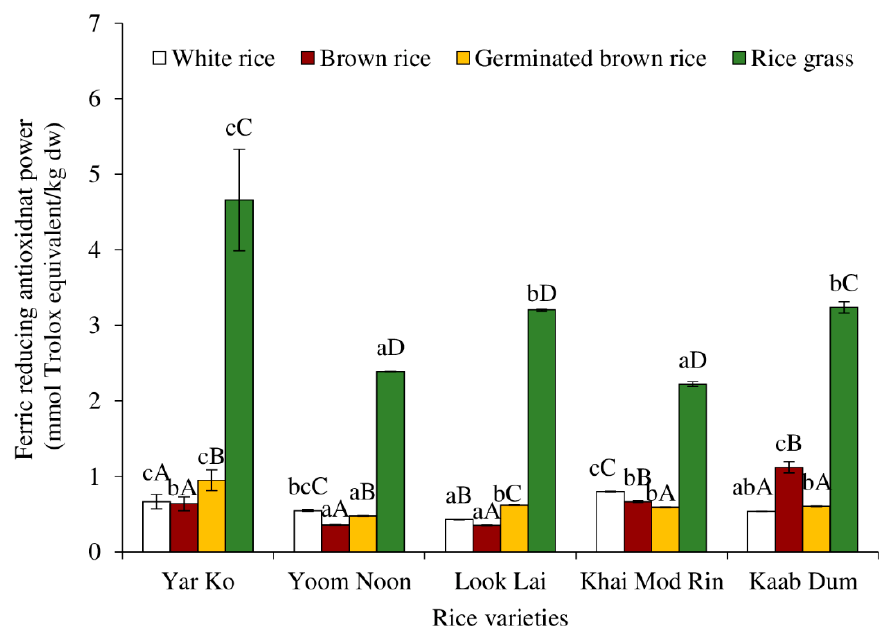
Figure 8. Effect of rice variety and processing condition on ferric reducing antioxidant power (FRAP) of aqueous extract of Thai indigenous rice. Bars represent the standard deviations from triplicate determinations. Different lowercase letters within the same processing condition indicate significant differences ( p ˂ 0.05). Different uppercase letters within the same variety indicate significant differences ( p ˂ 0.05).